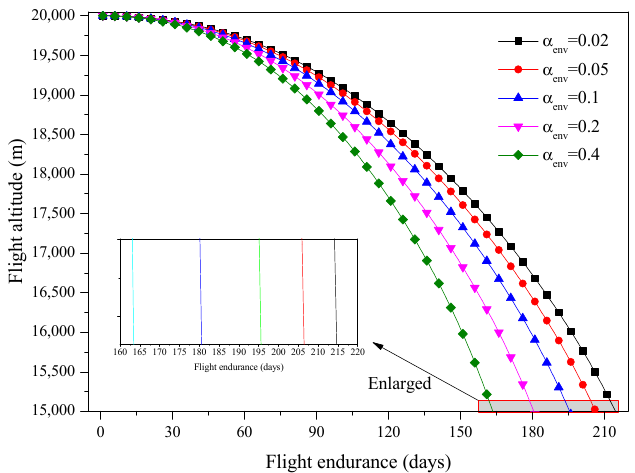
Figure 14. Effects of envelope absorptivity on the flight altitude.